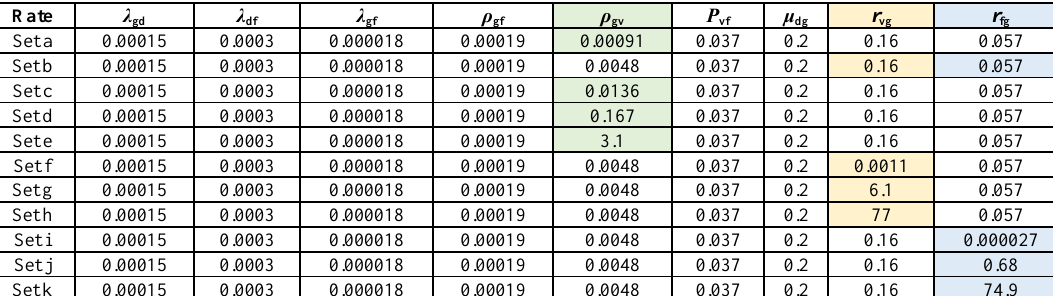
Table 1. CTMC model parameters (per